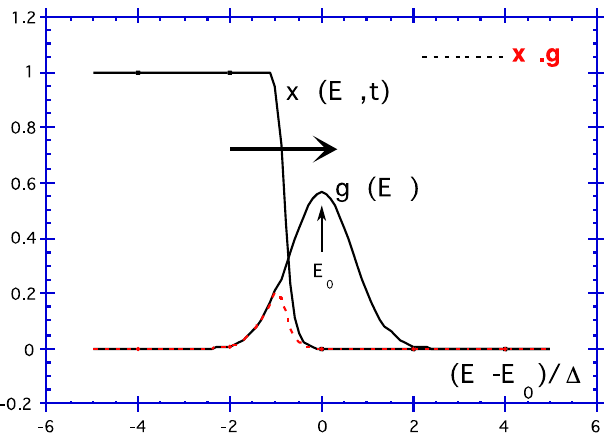
Figure 22. Progress of advancement degree along the distribution